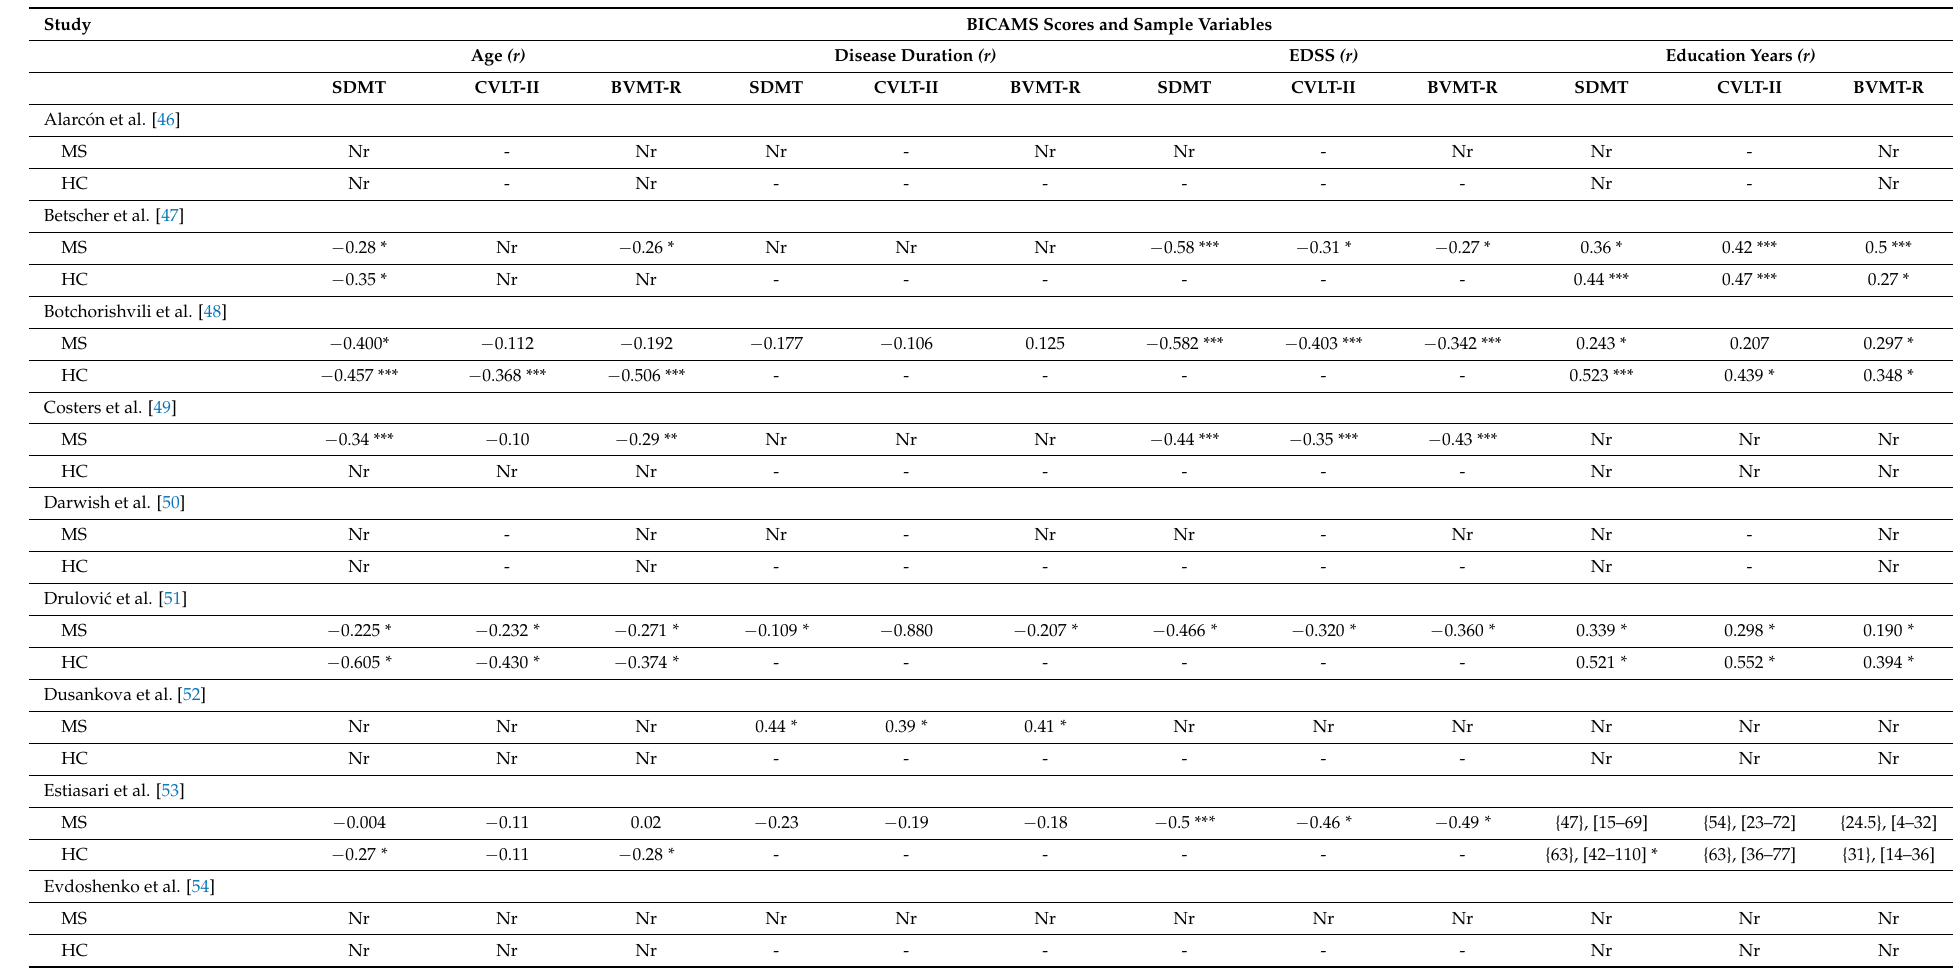
Table 4. Correlations between BICAMS scores and MS sample